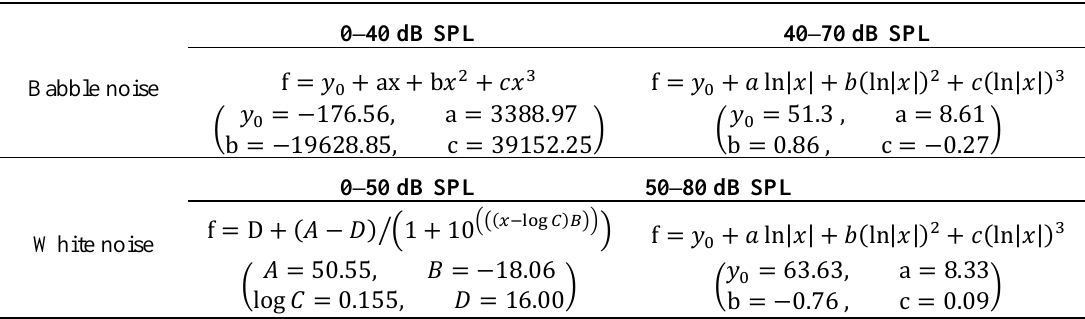
Table 2. Microphone Calibration Table.